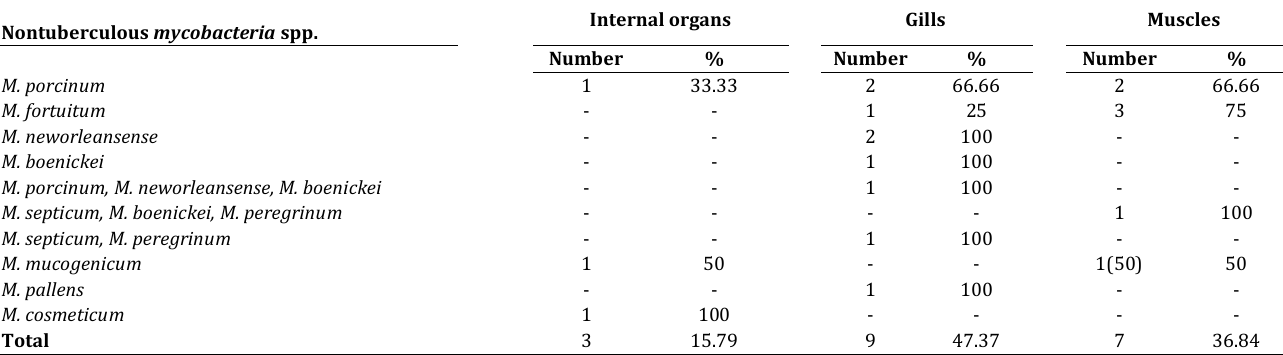
Table 1 . Numbers and percentages of nontuberculous mycobacteria (NTM) spp. isolated from fish internal organs, Gills, and Muscles